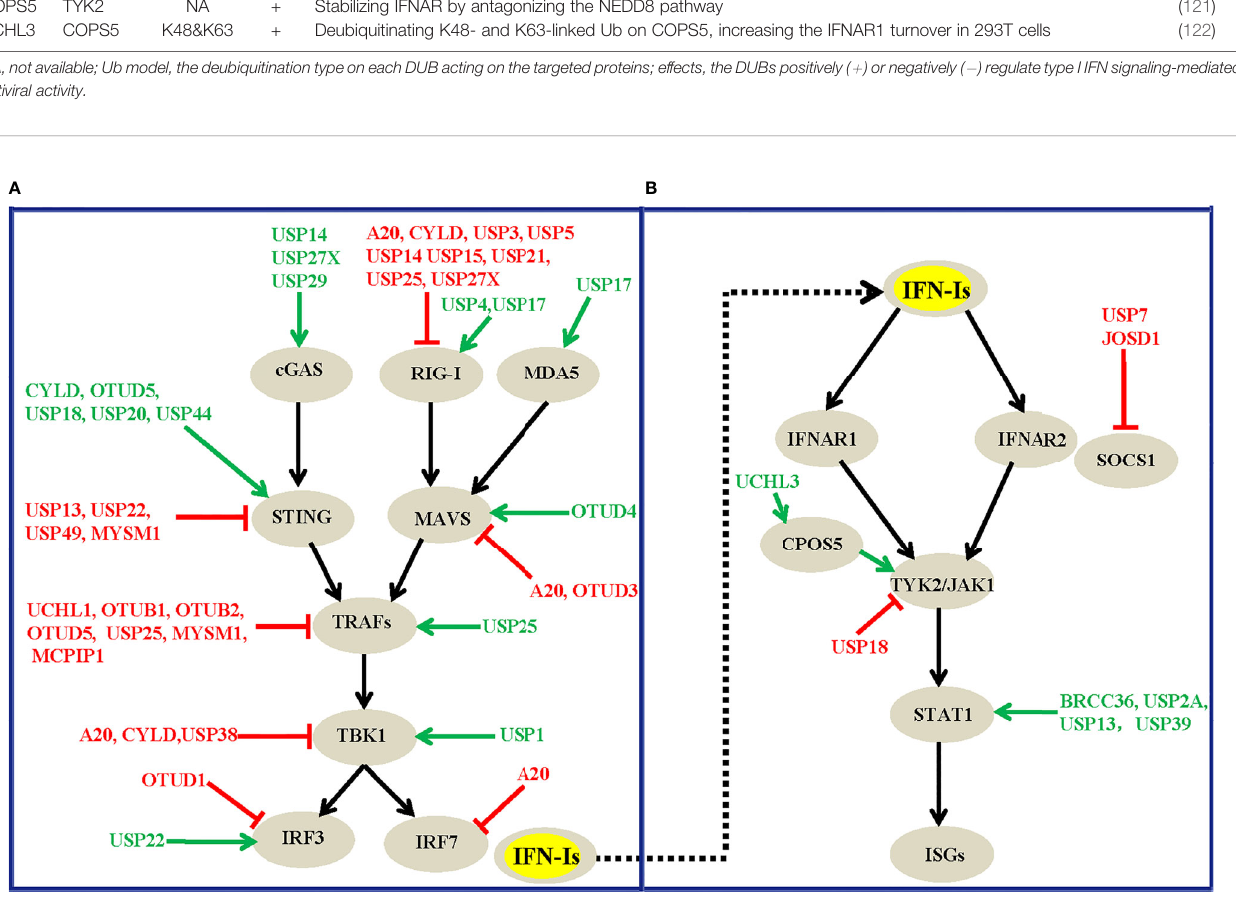
FIGURE 3 | Overview of DUBs that modulate the virus-induced IFN-I production signaling (A) and the IFNAR-mediated downstream signaling transduction pathway (B) . The green arrows and red lines respectively indicate the positive and negative regulatory roles of each DUB